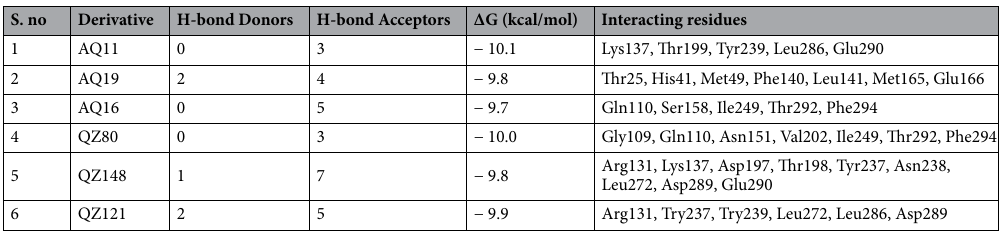
Table 1. Shortlisted AQ and QZ derivatives with interacting residues of M pro .